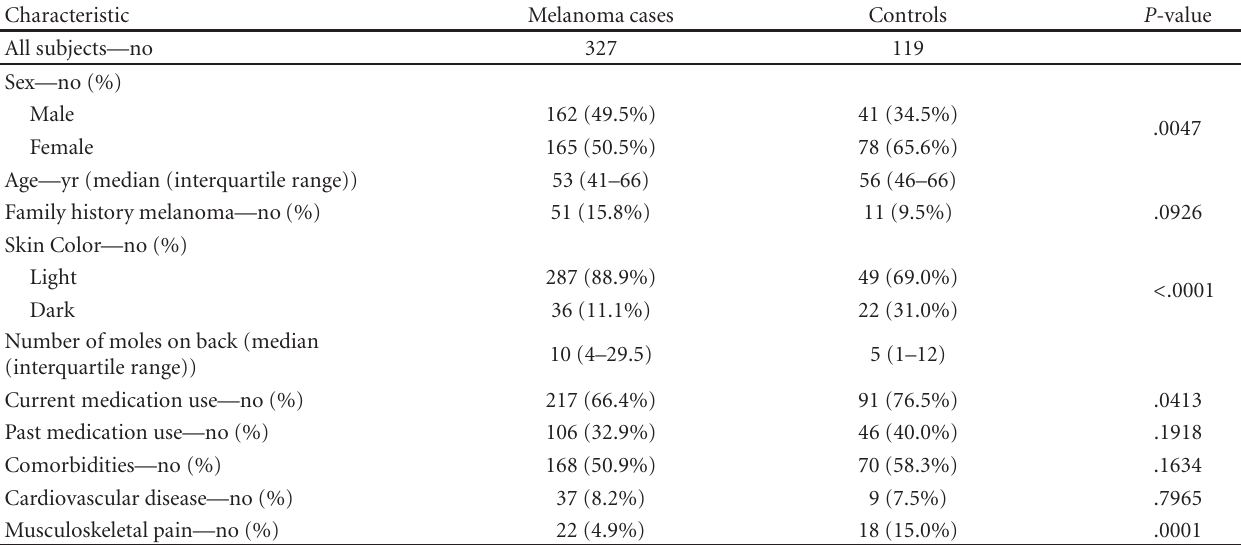
Table 1: Demographic